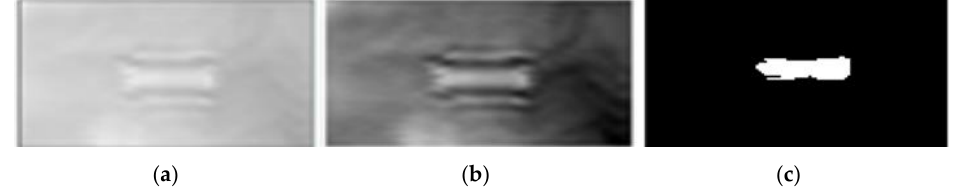
Figure A2. Images of notch 1 under the 2 mm-thick rubber layer obtained at a standoff distance of 4 mm: ( a ) original and after ( b ) average filtering and ( c ) thresholding by the developed fuzzy c-mean thresholding algorithm.